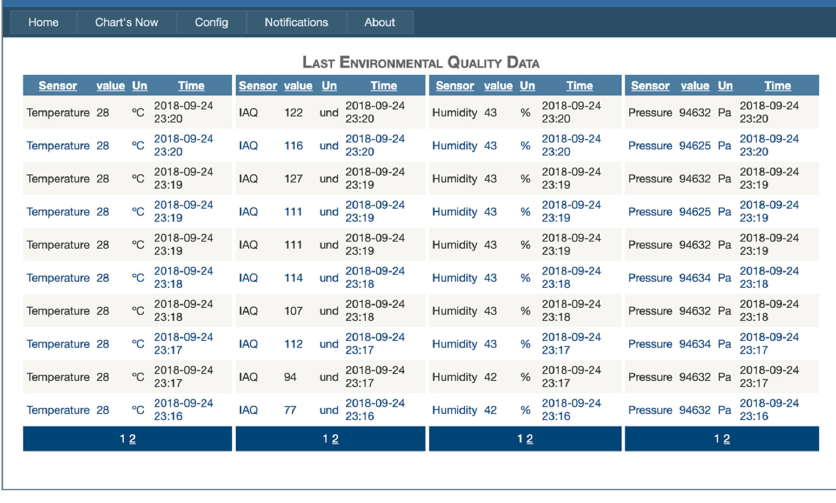
Figure 4. iAQ+Web .